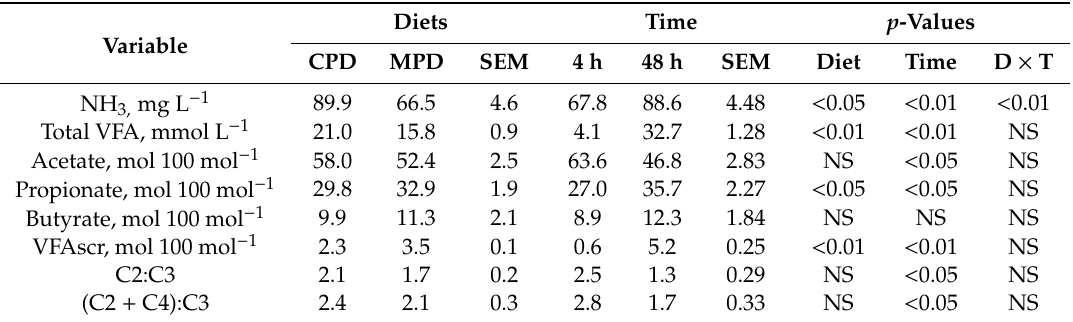
Table 6. Least square means for the production and concentration of volatile fatty acids (VFAs) and the concentration of ammonium (NH 3 ) for both